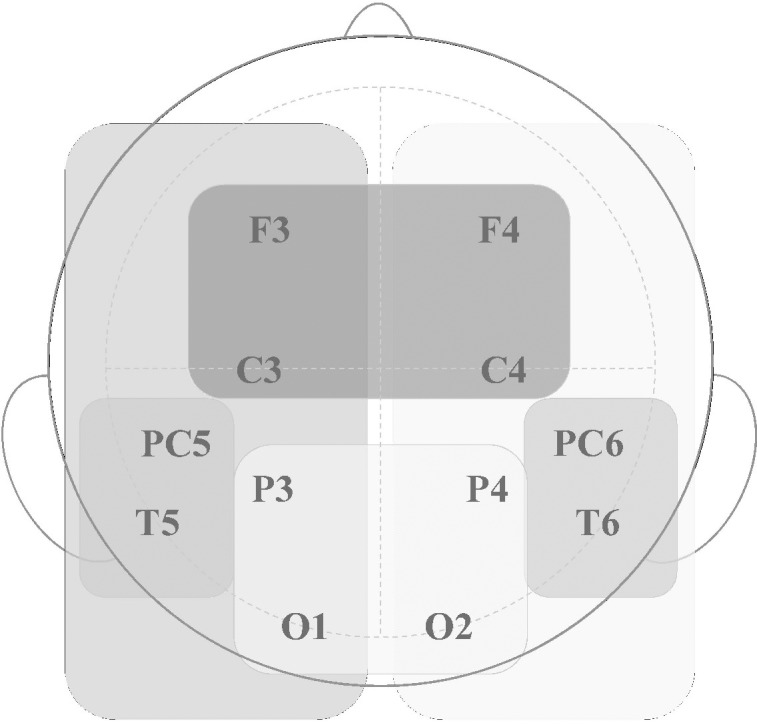
Layout of the electrode sites: Three bands, subdivided by hemisphere.